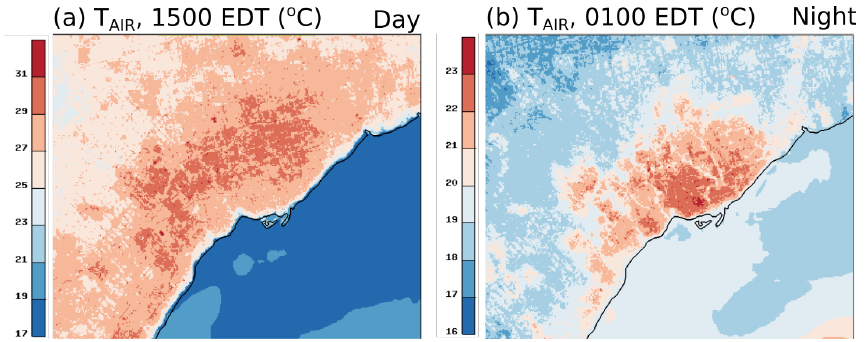
Figure 9. TOR-GEM250 maps of near-surface air temperature (°C) at ( a ) 1500 EDT and ( b ) 0100 EDT, averaged for 5 days classified with a low-deformation lake-breeze type for Lake Ontario (10, 11, 27, 28 July and 15 August